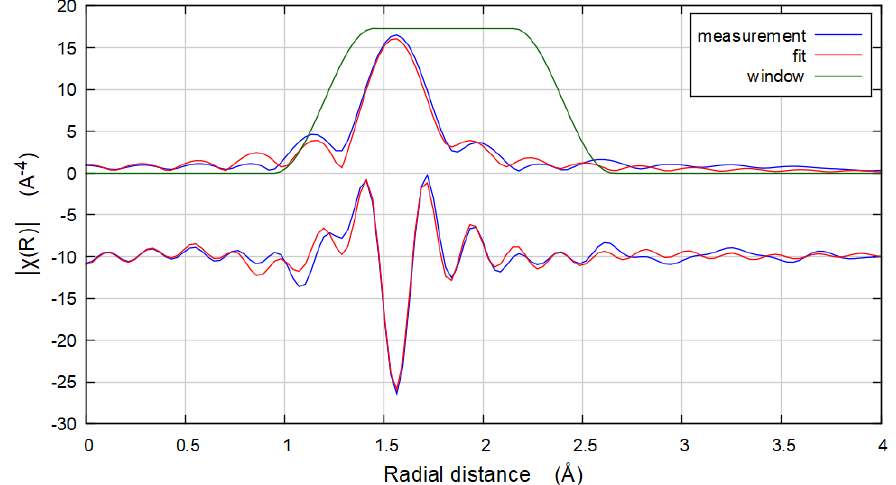
Figure 8. EXAFS fit (magnitude (top) and real part (bottom)) to the Cs 5 Nb 3 O 3 F 14 specimen using the single crystal model. Real space data were not plotted with phase shift correction, so bond lengths appear shorter than reported. Fitting parameters include: amplitude reduction factor = 0.83(7) and energy zero = − 0.2(9) eV using three paths for the nearest neighbor oxygen and two nearest neighbor fluorine ions with Debye-Waller factors fixed at values of 0.001 A2. Refinement R factor = 0.03 with reduced chi-squared of 2529.